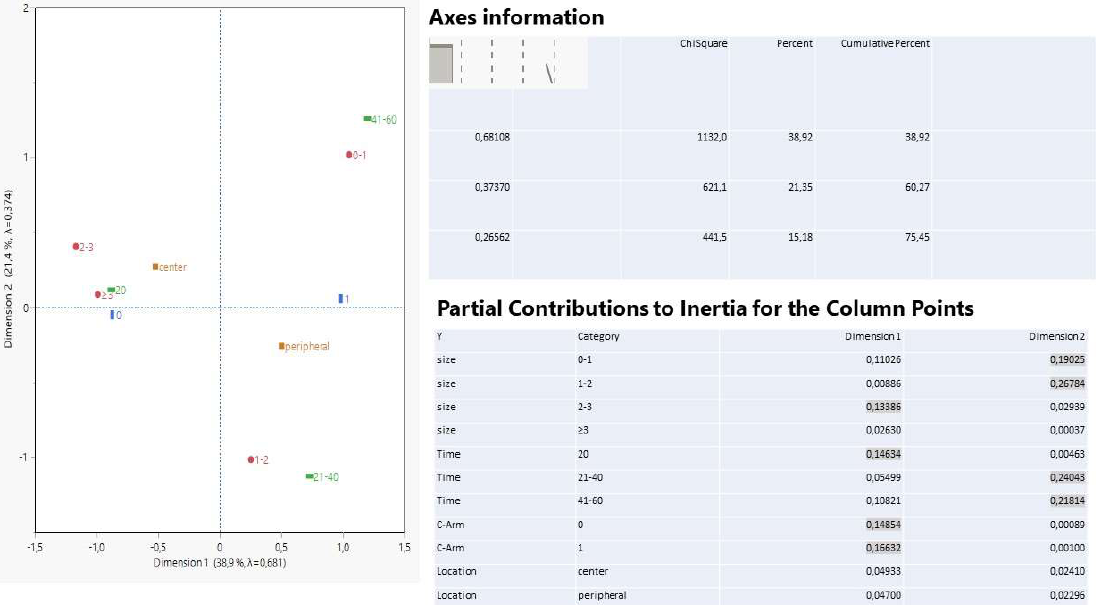
Figure 7. Multiple correspondence analysis among categories of four variables: tumor location, lesion size, method of lung penetration, and the number of slices entered as a supplementary variable. Points positioned in close approximation indicate strong affiliation, and distant points from the center indicate a strong effect on either dimension. The highlighted coordinates reveal a comparatively higher correlation with each dimension.